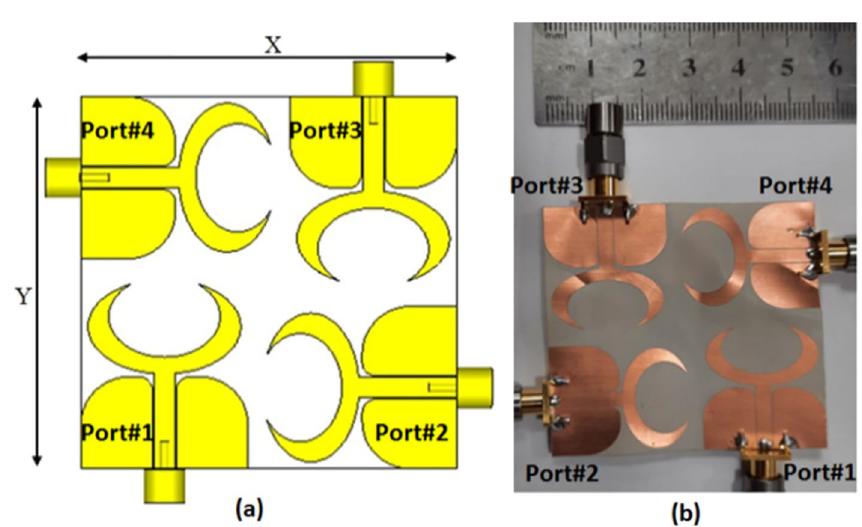
Figure 7. Flexible MIMO antenna configuration ( a ) 2 D view, ( b ) fabricated photo